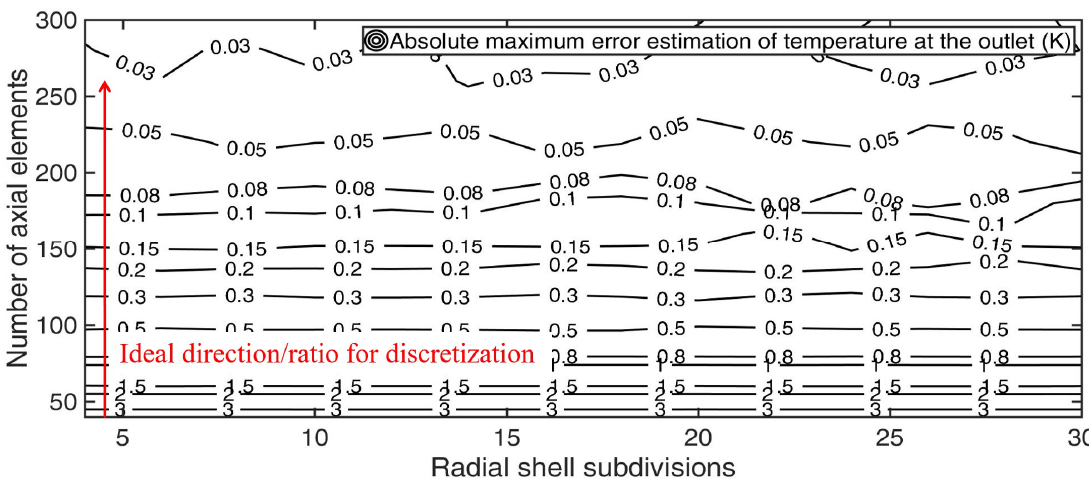
Figure 18. Computation times of the composite model tests (Case 1).